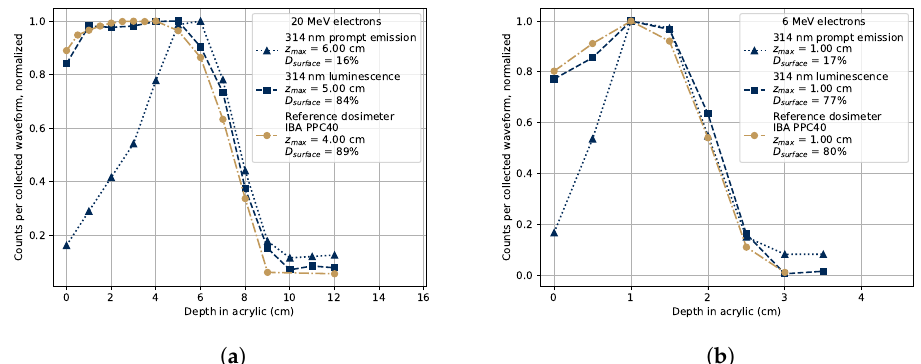
Figure 4. Generated light intensity in the sample as a function of depth in acrylic at 314 nm. The RIL after the electron pulse (squares) and the prompt light signal (triangles) were separated as in Figure 3. The response of a reference dosimeter, an IBA PPC40, is included in the figures as a gold dash-dotted line. The figure legends display the depth at which the maximal dose was recorded, z max , and the surface dose (0 cm depth) fraction relative to the maximum dose as D surface . ( a ) 20 MeV electron beam. ( b ) 6 MeV electron beam.